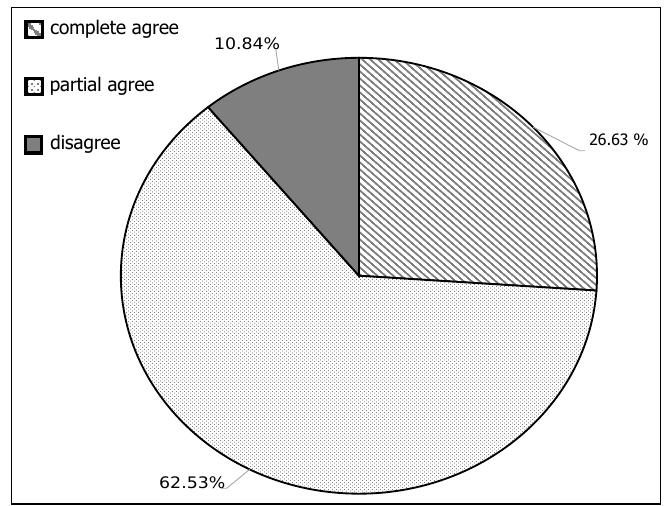
Figure 11. Participant agreement with the recommended classes.